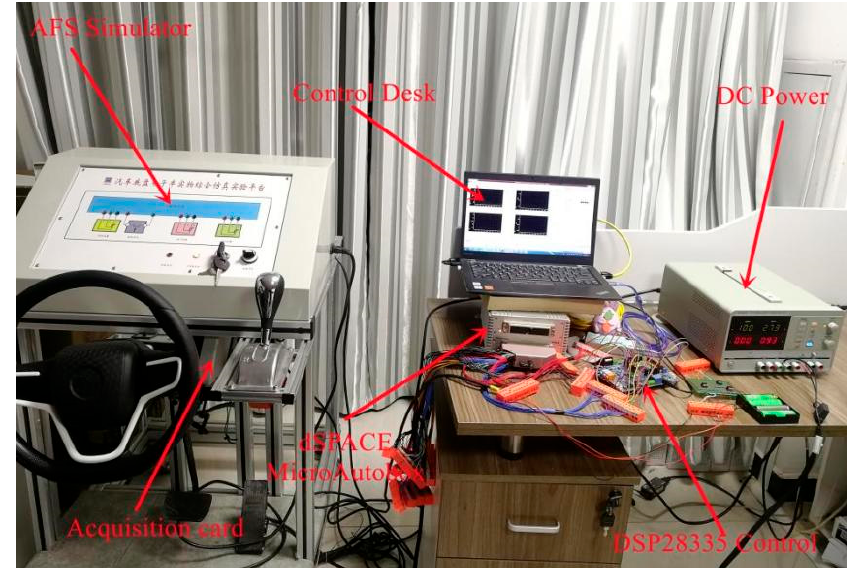
Figure 9. AFS-HIL test platform.